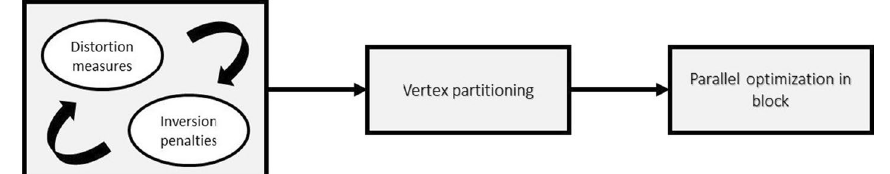
Fig. 2 High-level flowchart of the ABCD algorithm. First, a global descend field is applied alternatively on modified distortion measures and inversion penalties. Then, the vertex is partitioned and each block is locally optimized